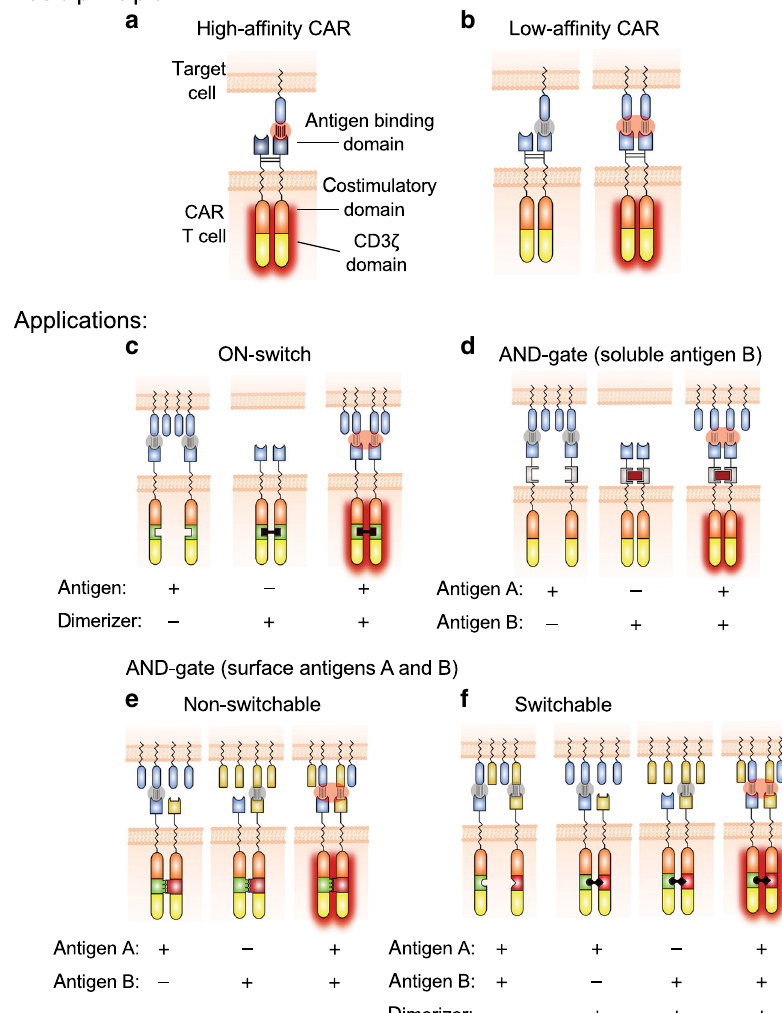
Fig. 1 Principle and applications of AvidCARs. a Schematic of a conventional CAR (high-af fi nity CAR) typically containing a high-af fi nity antigen-binding domain (usually a single-chain variable fragment, scFv) fused via a dimerizing hinge region (derived from, e.g., CD8 α ) to the cytoplasmic domains of a co- stimulatory receptor (mostly 4-1BB or CD28) and CD3 ζ . Due to high-af fi nity binding, monovalent interaction with the target antigen is suf fi cient for CAR activation. b Schematic of a low-af fi nity CAR in which a low-af fi nity antigen-binding domain is fused to the same conventional CAR backbone shown in ( a